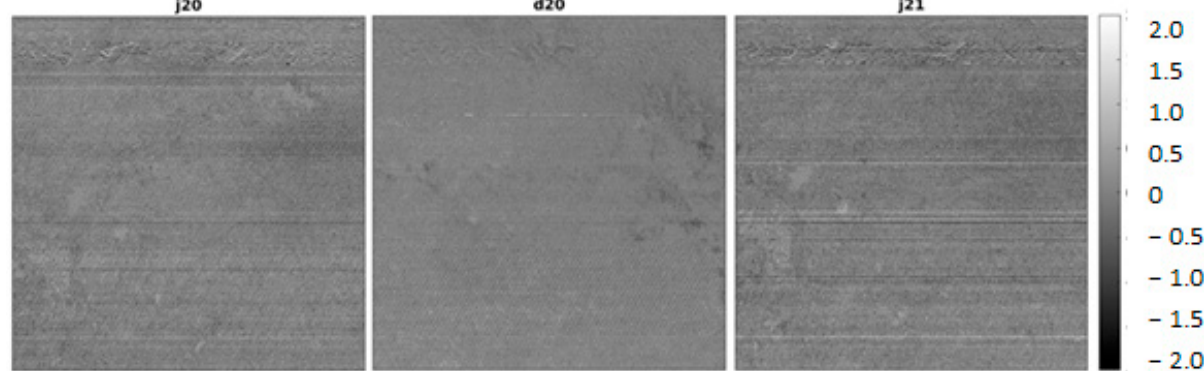
Figure 8. Residual noise for the 823.75 nm spectral band of different Pignola scenes from lines 300 to